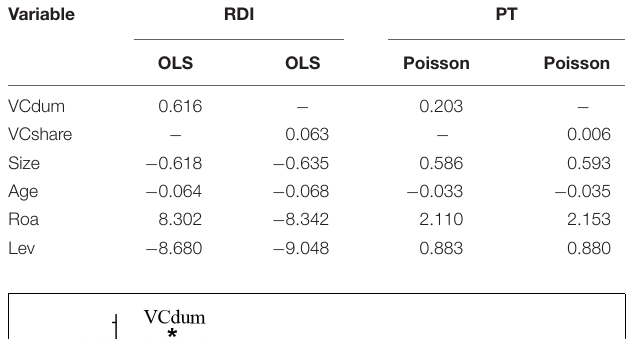
TABLE 6 | Moderating effects of product market competition in the relationship between venture capital and technological